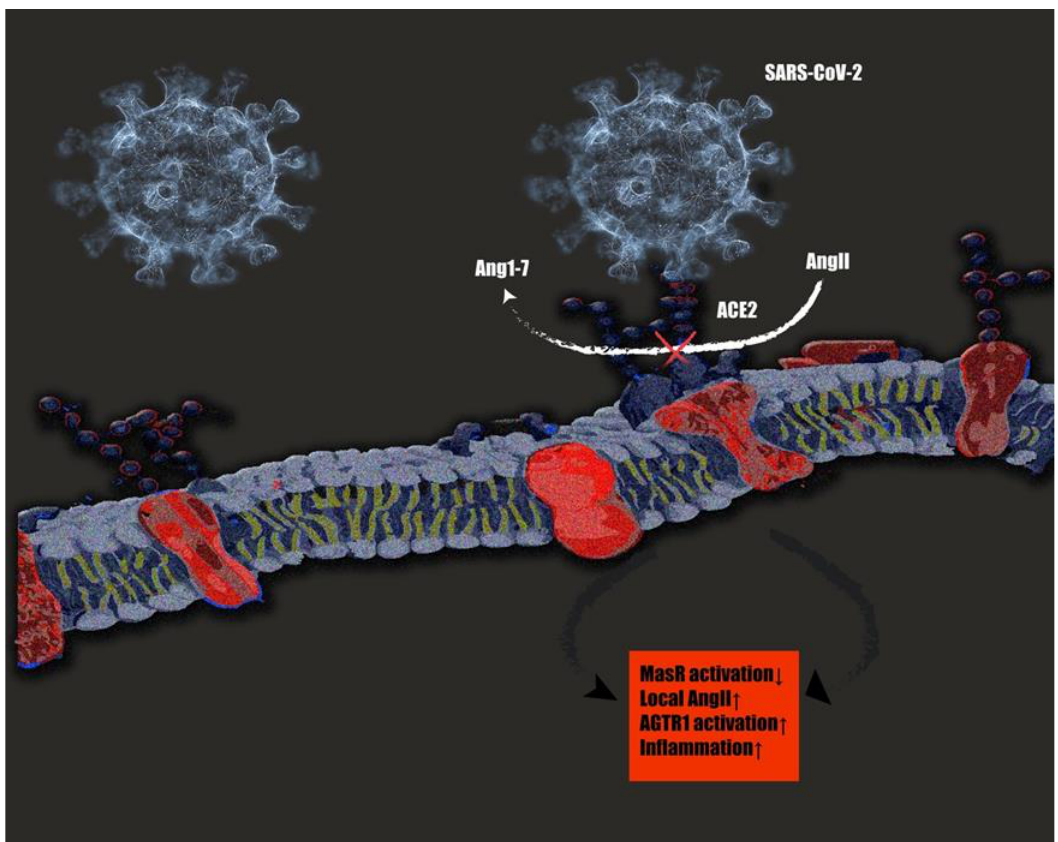
Figure 2. SARS-CoV 2 interactions with tRAS. SARS-CoV-2 binding on ACE2 inhibits the conversion of the pathological AngII to protective Ang1–7. The resulting increase in local angiotensin 2 (AngII) concentrations lead to an overactivation of the pathological AngII/angiotensin II receptor type 1 (AGTR1) axis, leading to a cytokine storm and resulting in overwhelming inflammatory reactions [169].